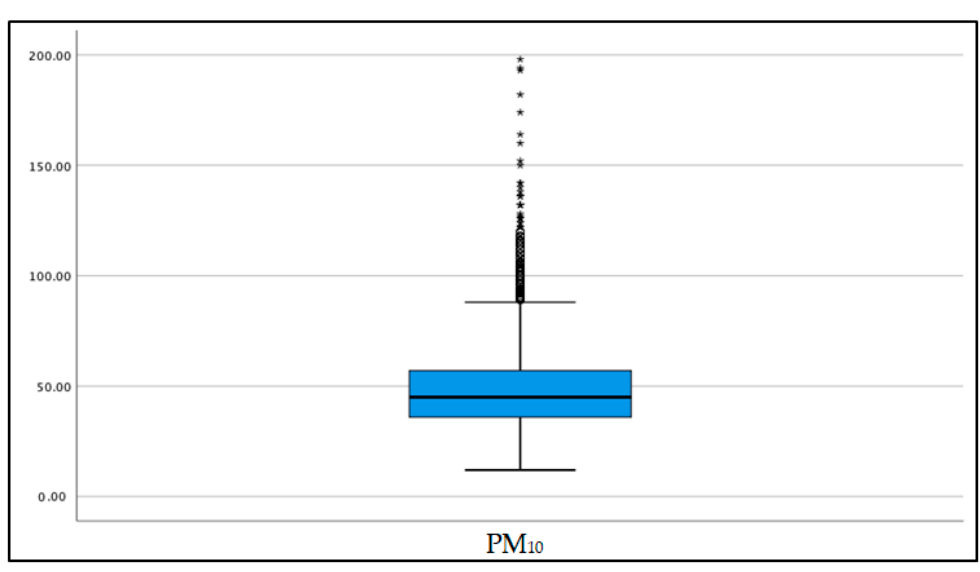
Table 4. The best splitting criteria for the decision tree.